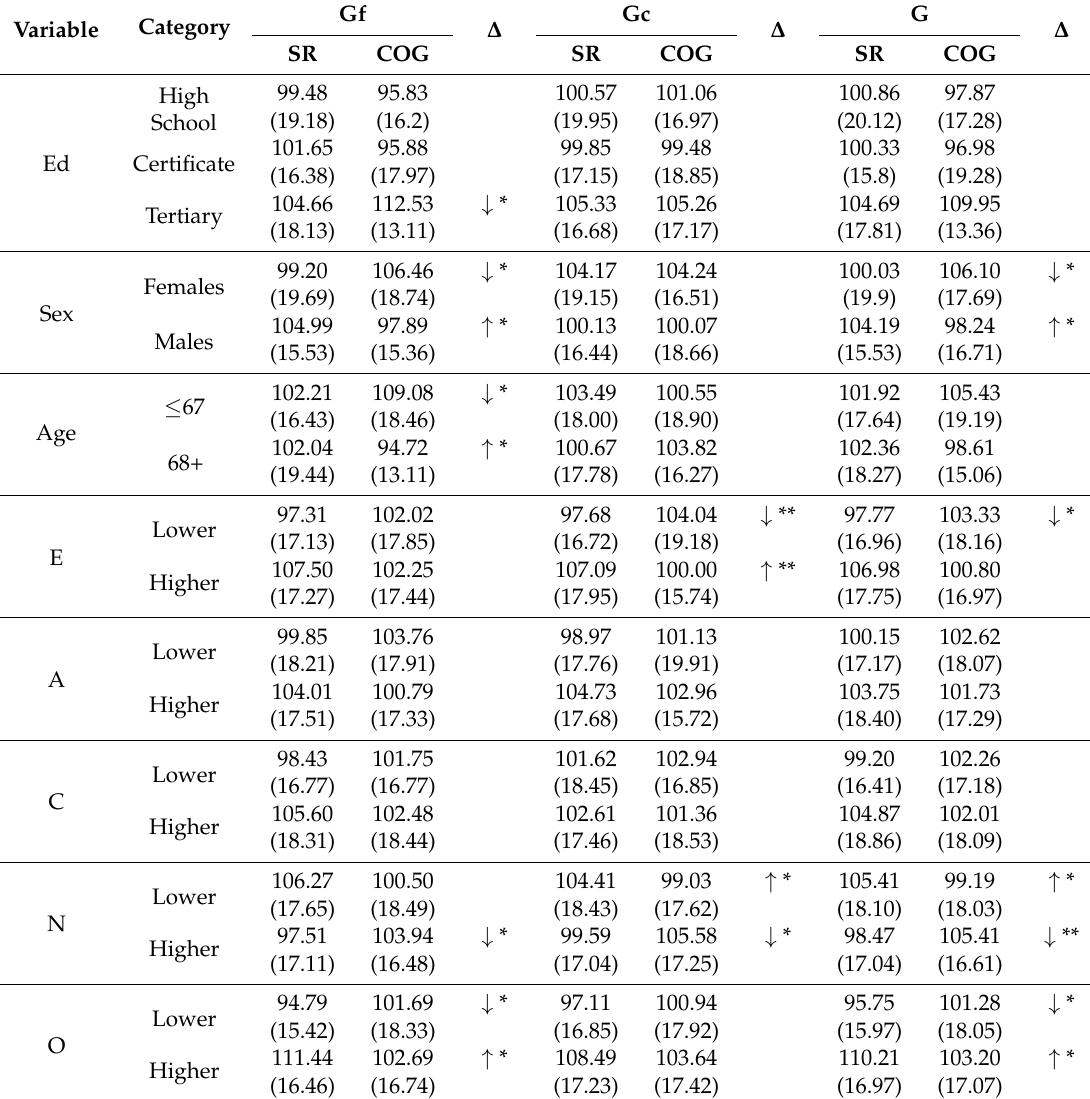
Table 5. Means, (SDs) and differences between IQ-equivalent SRMCA (SR) and cognitive performance (COG) scores across demographics and personality